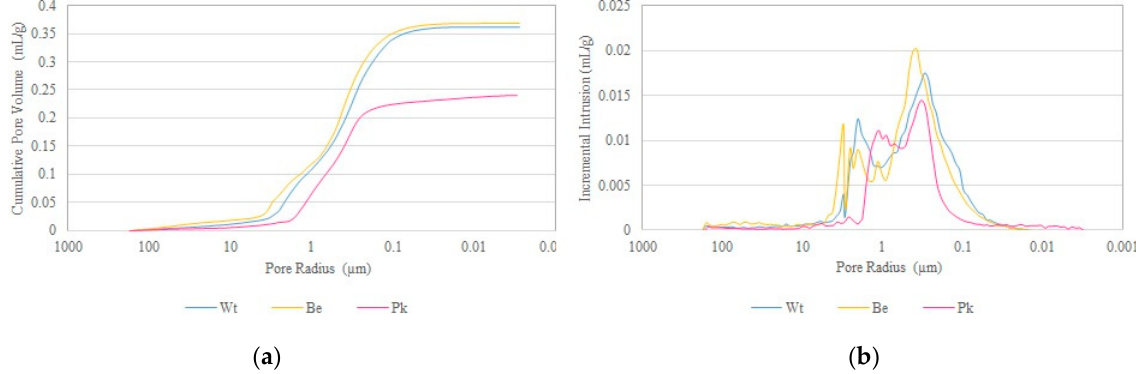
Figure 7. Hg porosimetry curves for the three ignimbrites. ( a ) Cumulative function. ( b ) Normal function associated with the pore range.